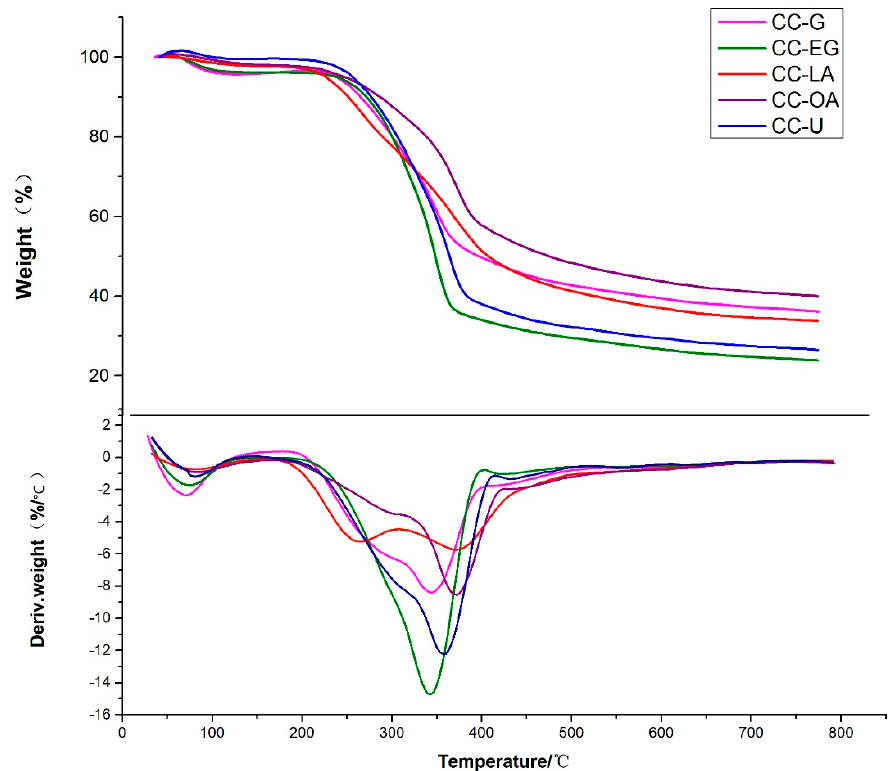
Figure 8. TG/DTG curves of lignin treated with different DESs.